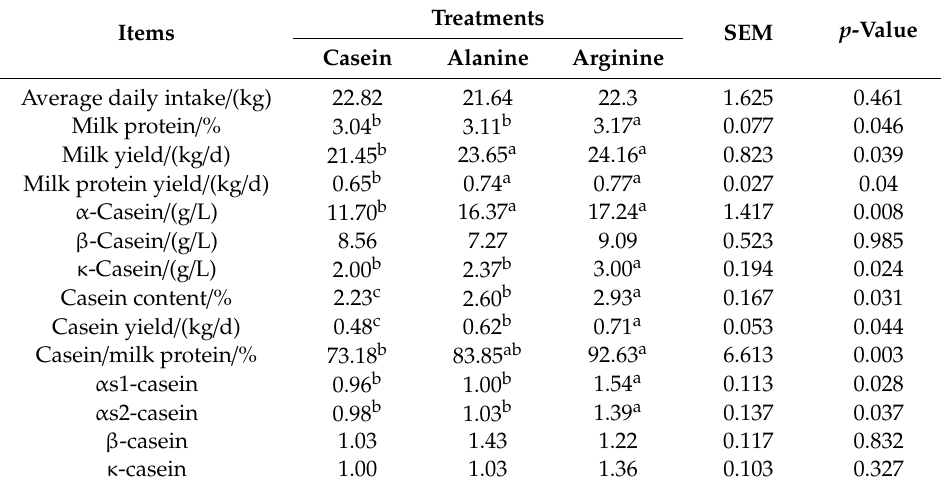
Table 7. E ff ect of jugular vein arginine infusion on the yield of milk protein and milk casein protein in Holstein